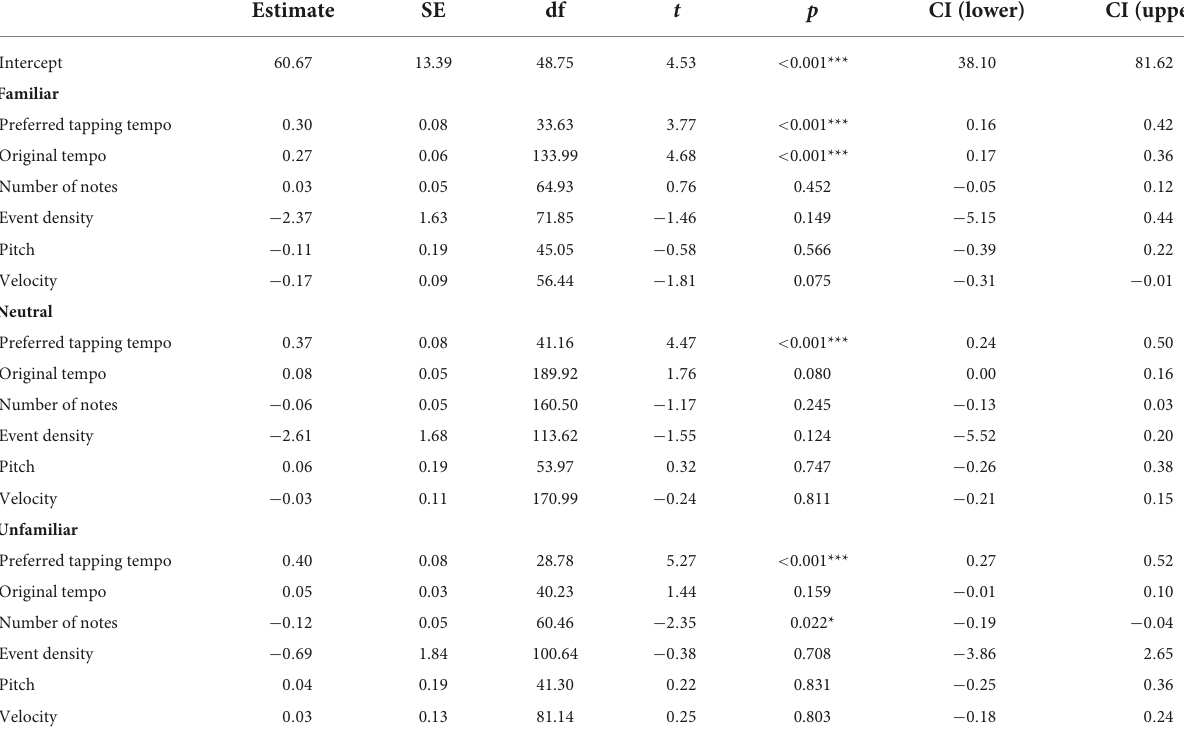
TABLE 1 Fixed effects table for the linear mixed model fitted to the preferred music tempo detected in the samples for the familiar, neutral, and unfamiliar music.